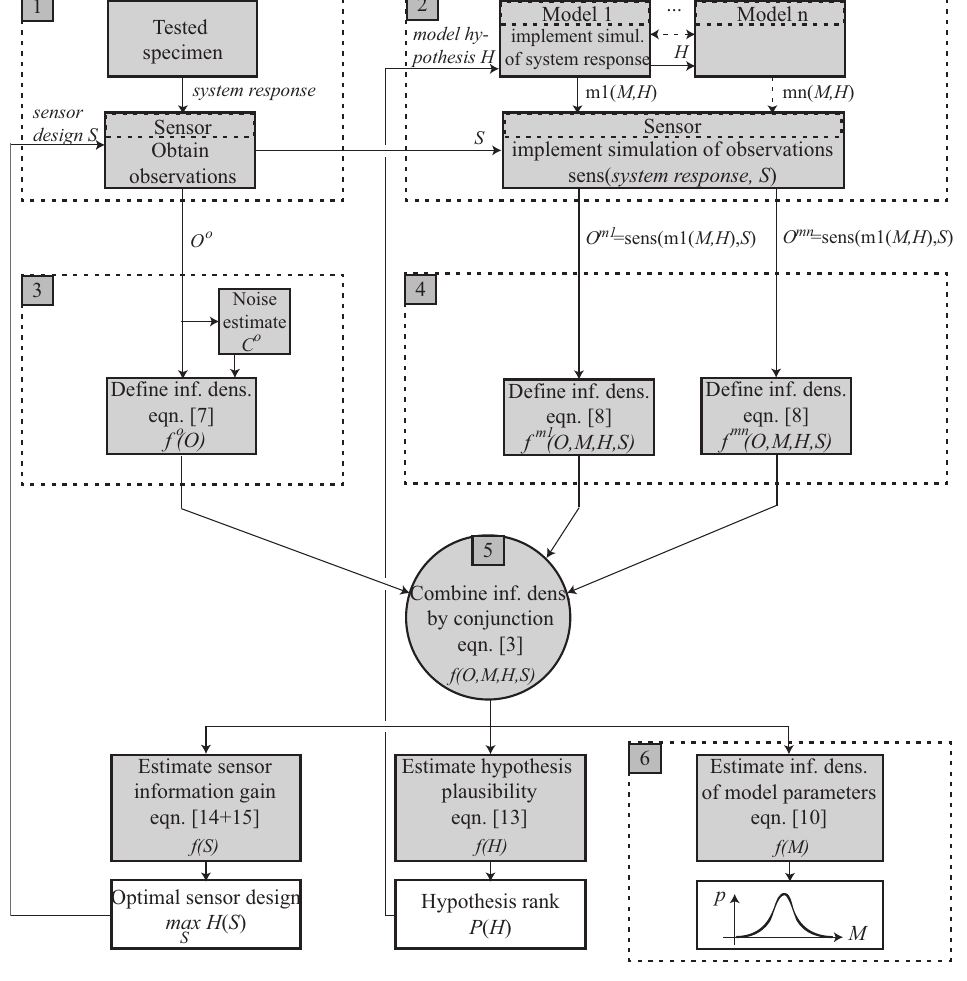
Figure 2. Flow chart of the complete information-theoretic probabilistic inverse problem. The abbreviation “inf. dens.” is referred to information